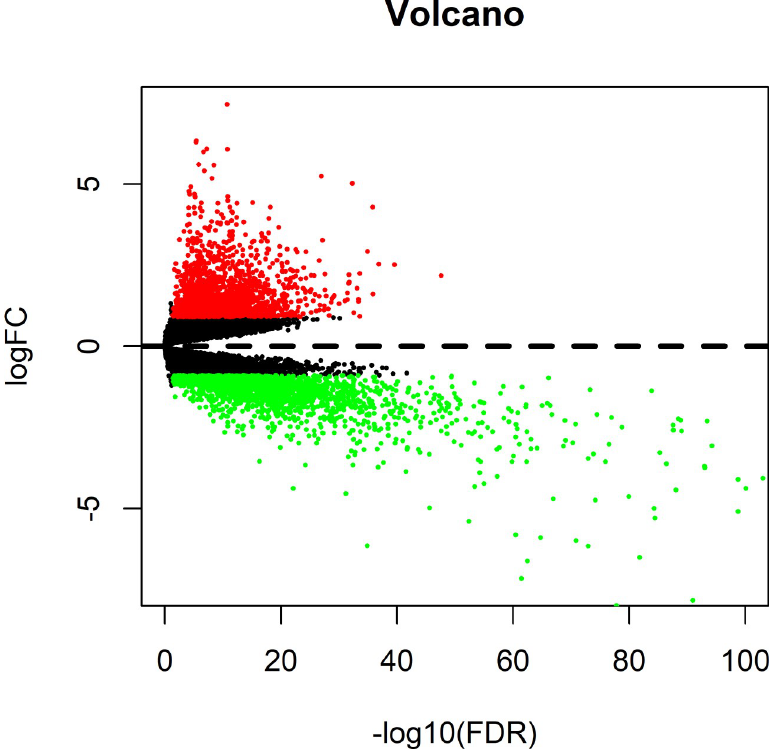
Fig 2. DElncRNAs between prostate cancers and non-carcinoma tissue samples. Red dots represent differentially upregulated lncRNAs, green dots represent differentially downregulated lncRNAs and then dark dots represent no differentially expressed